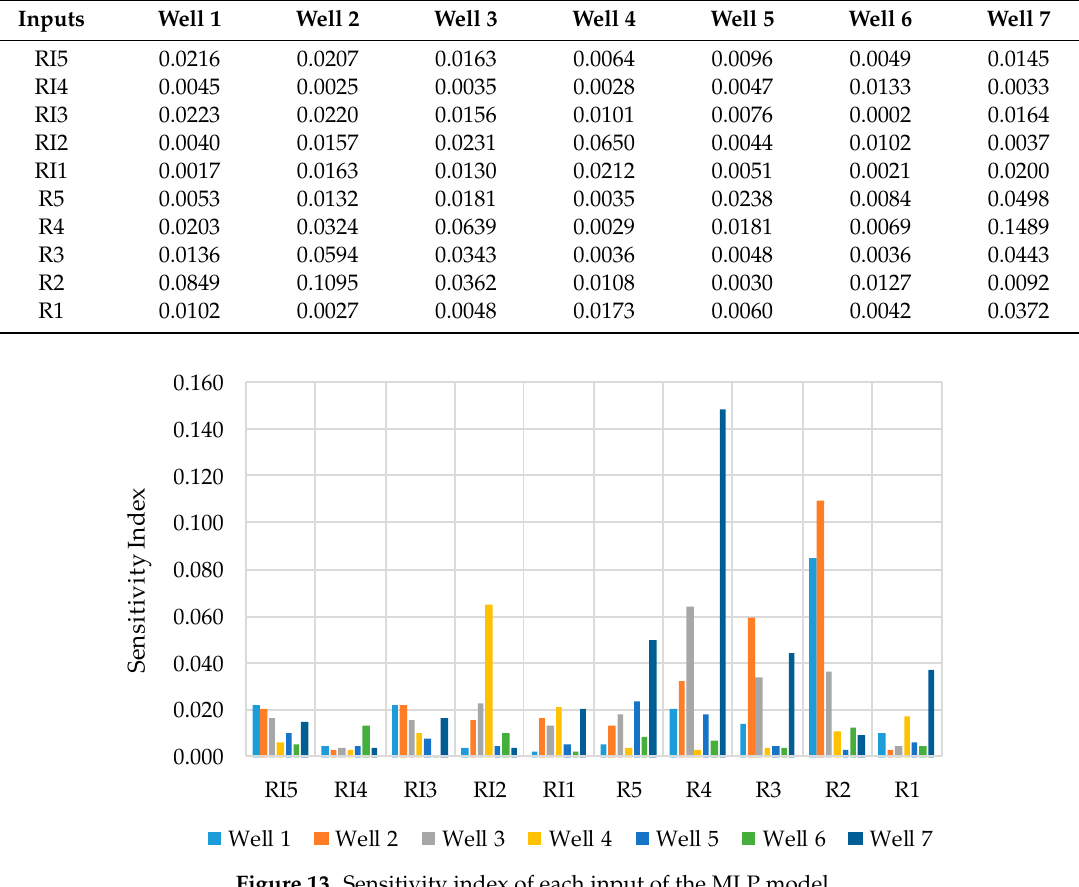
Figure 13. Sensitivity index of each input of the MLP model. Table 5. Categorization of sensitivity and associated ranks.